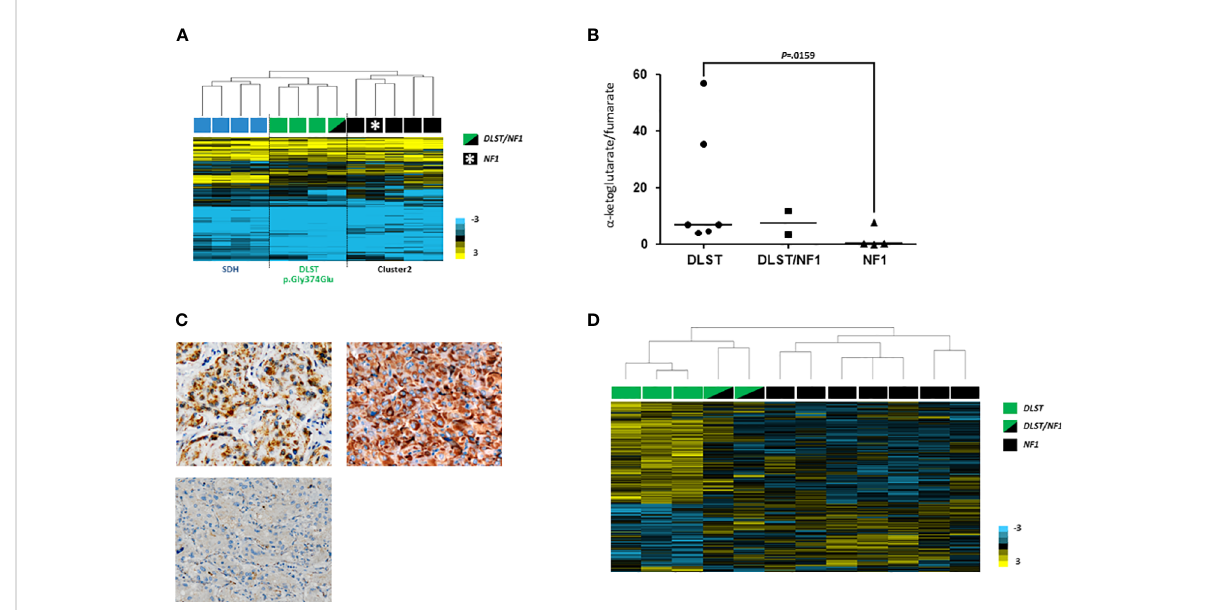
FIGURE 2 (A) Hierarchical clustering performed on the basis of methylation data from PPGLs as follows: one of the two DLST / NF1 (indicated with a green and black rectangle), four SDH-mutated (indicated with blue rectangles), three DLST -mutated (indicated with green rectangles) and fi ve cluster 2-mutated (denoted in black rectangles) PPGLs. The DLST/NF1 PPGL was grouped with DLST -mutated tumours, and separated from cluster 2- mutated PPGLs. City-block and complete linkage characteristics were used for the analyses. (B) a -ketoglutarate/fumarate ratios assessed by LC- MS/MS in DLST -mutated tumours (n = 6), NF1 -mutated PPGLs (n = 4), and the two tumours carrying dual NF1 / DLST mutations. Black lines represent medians. A t test identi fi ed signi fi cant differences between DLST -mutated and NF1 -mutated tumours. (C) Immunostaining for DLST was conducted in the two tumours carrying DLST / NF1 dual mutations (upper panel) revealing the characteristic cytoplasmic aggregates (x20). A VHL-mutated tumor was used as a negative control (lower panel) (D) Hierarchical clustering of the two NF1 / DLST mutated tumours, three DLST - and seven NF1 -mutated PPGLs based on gene expression data from a previously reported list of genes differentially expressed in DLST - mutated PPGLs. The two tumours carrying the NF1 / DLST mutations were clustered between PPGLs carrying mutations in NF1 and DLST . Uncentered correlation and complete linkage characteristics were used for the